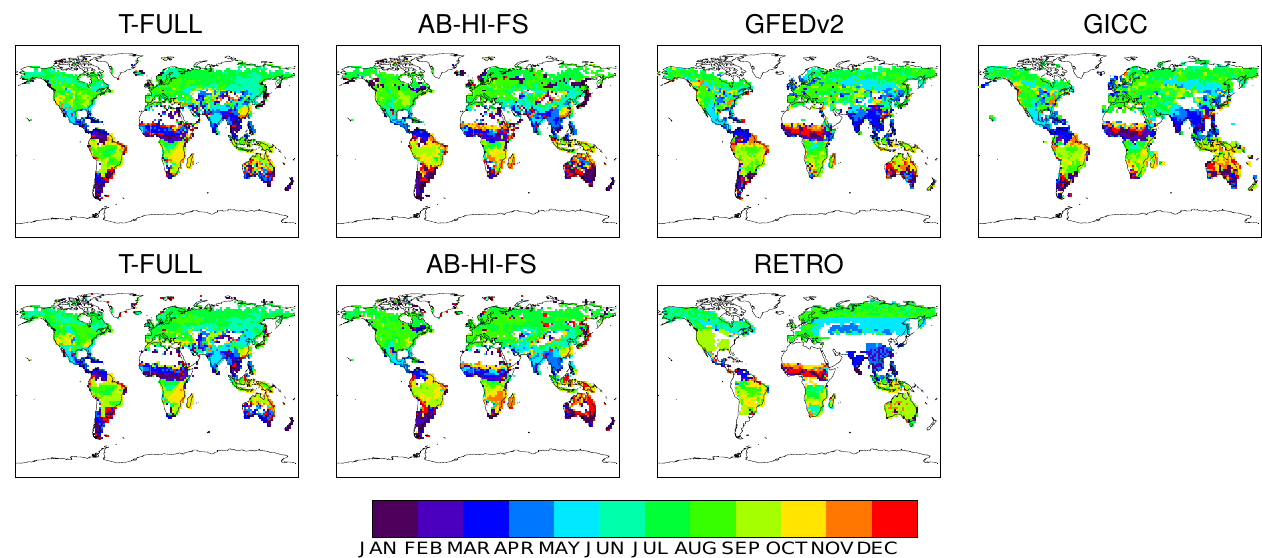
Fig. 6. Month of maximum total (wildfire plus deforestation) fire carbon emissions for the different simulations compared to different fire products: GFEDv2 (van der Werf et al., 2006), GICC (Mieville et al., 2010) and RETRO (Schultz et al., 2008). The model simulations are averaged over the corresponding observational periods (GFEDv2, GICC: 1997–2004; RETRO: 1960–2000). precipitation area burned carbon emissions